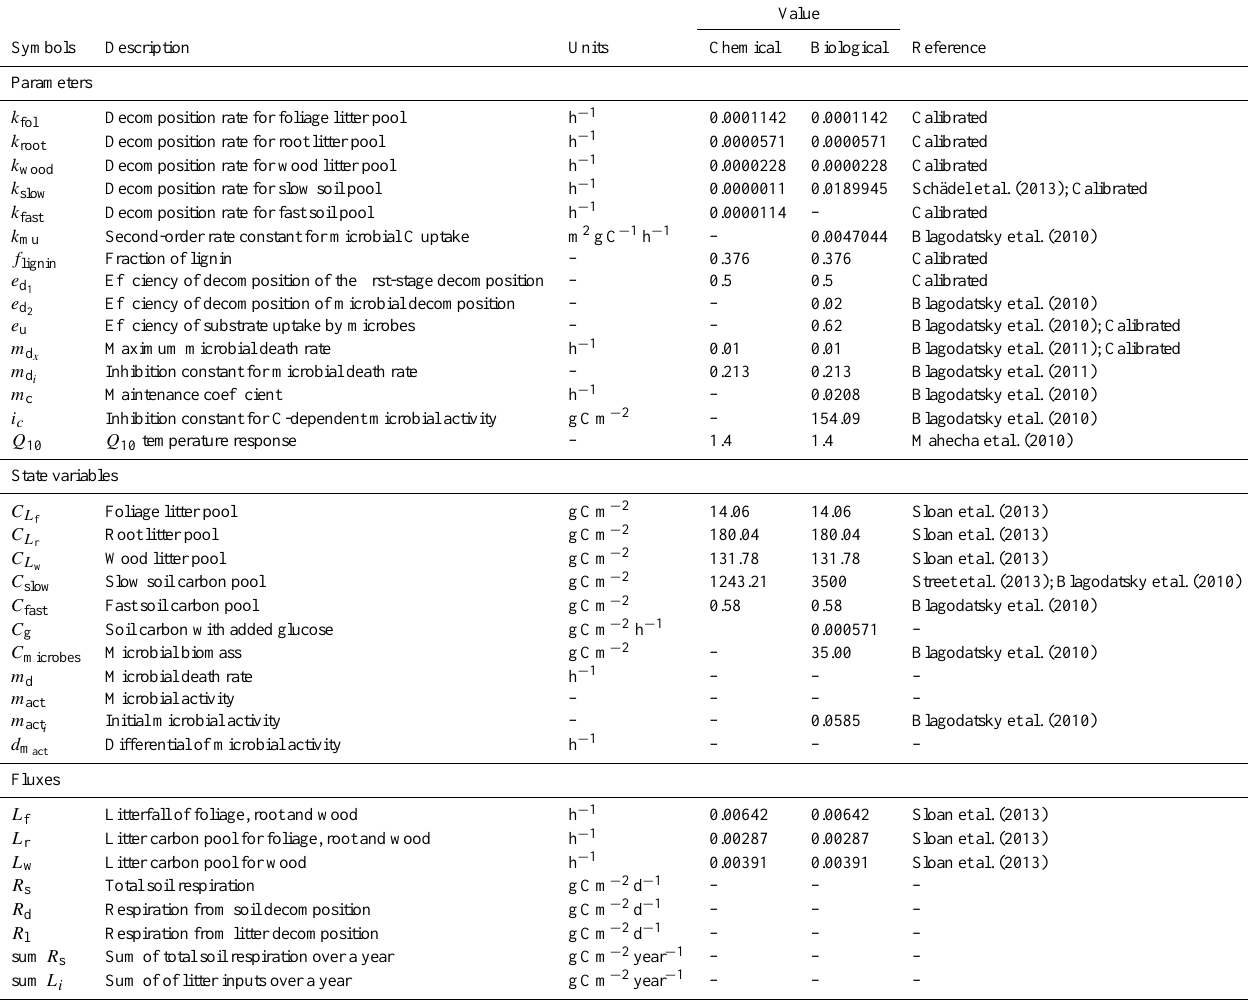
Table 1. State variables, parameters and fluxes of both the biological and chemical model.